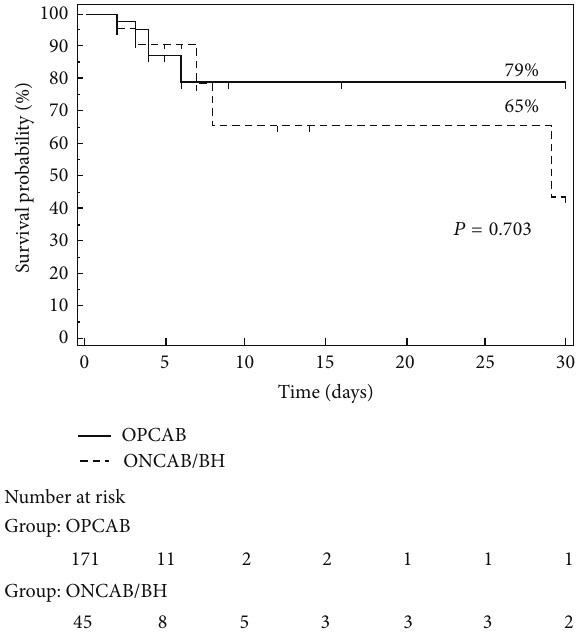
Figure 1: Kaplan-Meier curves for operational survival. Compar- ison of operational survival between patients undergoing OPCAB and those undergoing ONCAB/BH technique. 𝑃 value calculated by the log-rank test was